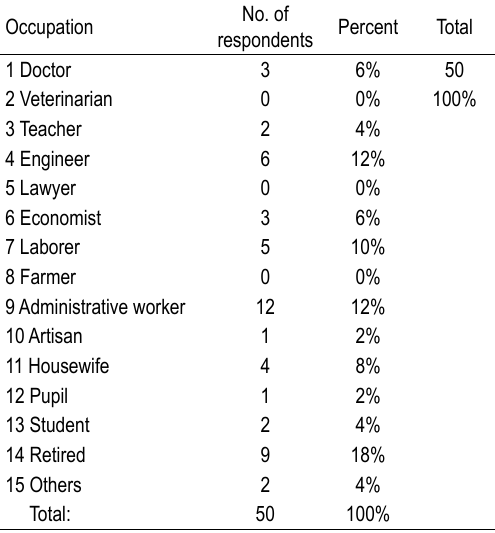
Table 3. Structure of respondents by occupation